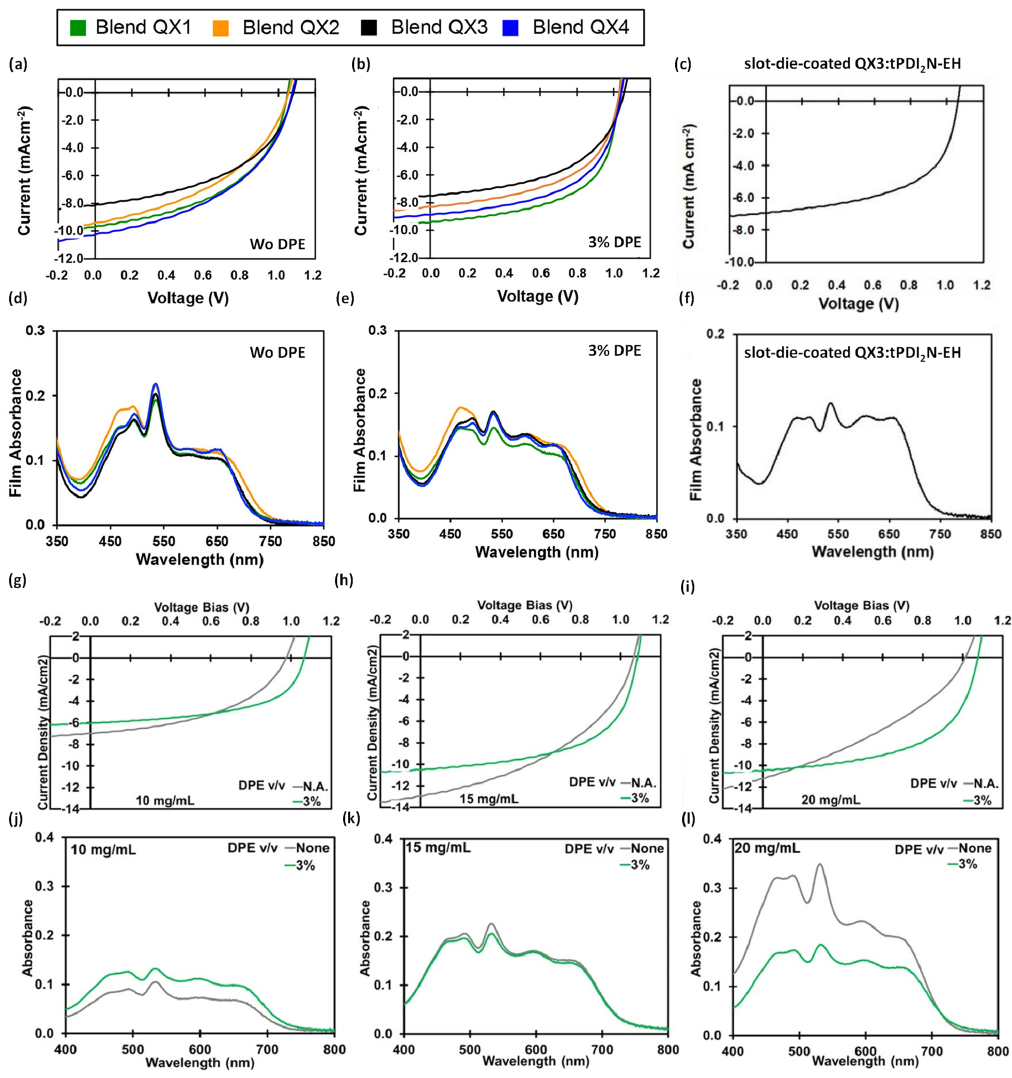
Figure 14. ( a , b ) Device J – V curves of spin-coated OPVs using the QX1–QX4: tPDI 2 N-EH (1:1 blend) active layer processed from o -xylene without and with 3% DPE additive, ( c ) device J – V curves of slot-die-coated OPVs using the QX3: tPDI 2 N-EH (1:1 blend) active layer processed from o -xylene without and with 3% DPE additive, ( d – f ) corresponding UV–Vis spectrum of the previous conditions, respectively, ( g – i ) device J – V curves of slot-die-coated OPVs using the QX3: tPDI 2 N-EH (1:1 blend) active layer processed from toluene without and with 3% DPE additive at di ff erent total concentrations, ( j – l ) corresponding UV–Vis spectrum of the previous conditions, respectively. ( a – f ) and ( g – l ) reproduced with permissions from [100], [101] respectively. Copyright 2019 American Chemical Society.